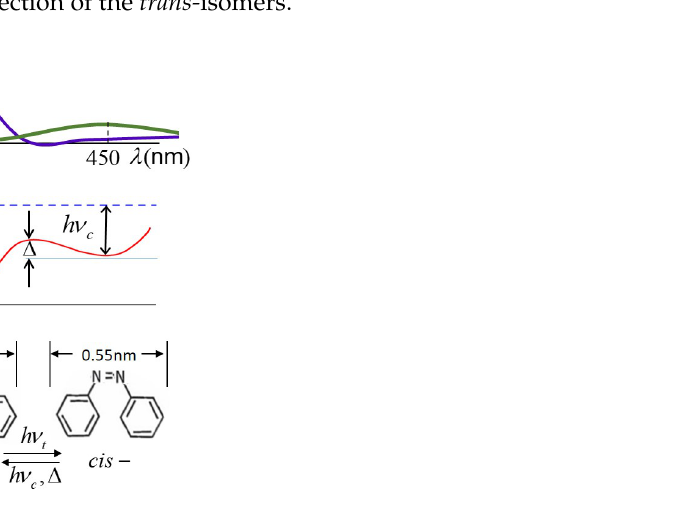
Figure 2. Schematics of ( a ) absorption spectra, ( b ) energy landscape [15], ( c ) isomer shapes and structures, and isomerization